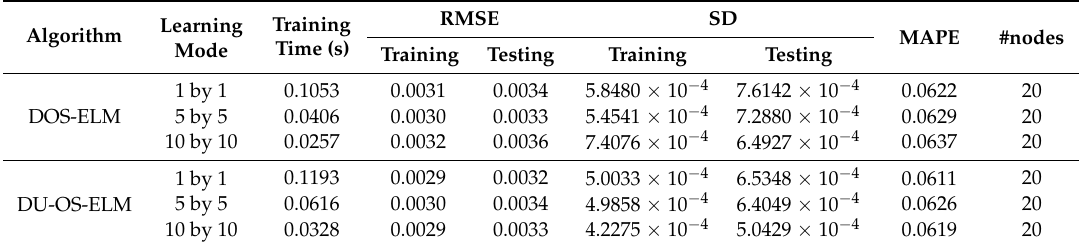
Table 4. Comparison results of DU-OS-ELM and